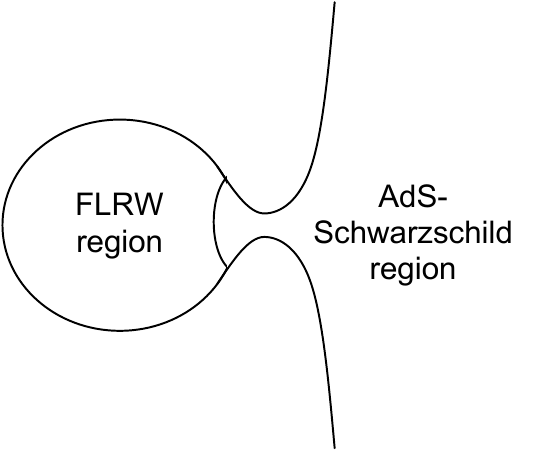
Figure 1 . A moment of time symmetry in a bag-of-gold spacetime. The region outside the minimal surface is precisely AdS-Schwarzschild, as is a small part of the interior. The rest of the interior is a (say, radiation dominated) FLRW